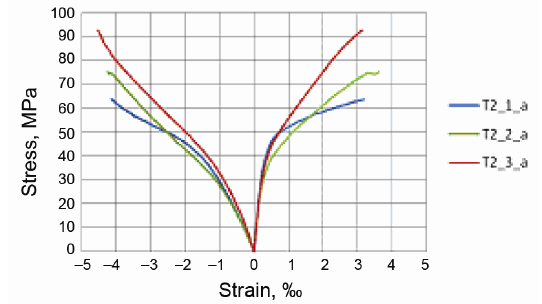
Fig. 14. Monotonic stress-strain curves for T 2_1_a, T 2_2_a and T 2_3_a